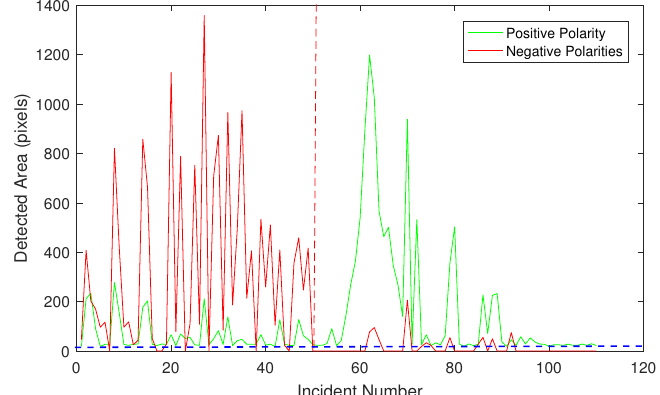
Figure 7. The red line shows negative-polarity and green illustrates positive-polarity changes, x -axis illustrates the incident number and y -axis shows the size of detected